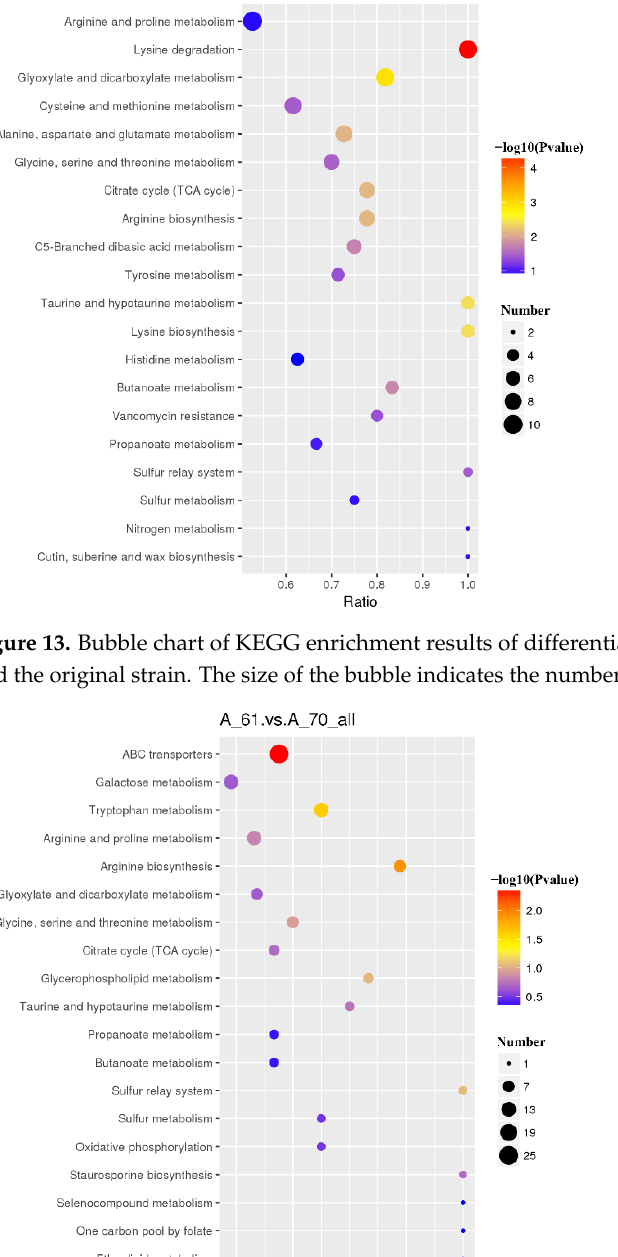
Figure 12. Bubble chart of KEGG enrichment results of differential metabolites between mutant 61 and the original strain. The size of the bubble indicates the number of genes enriched in the path ‐ way.